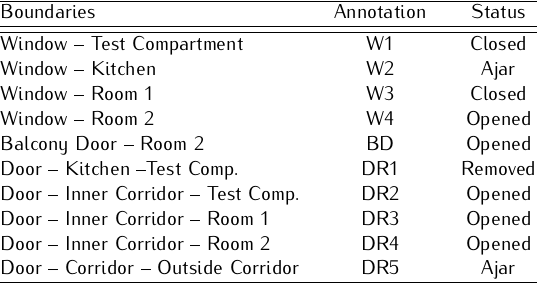
Table 1. Doors and windows